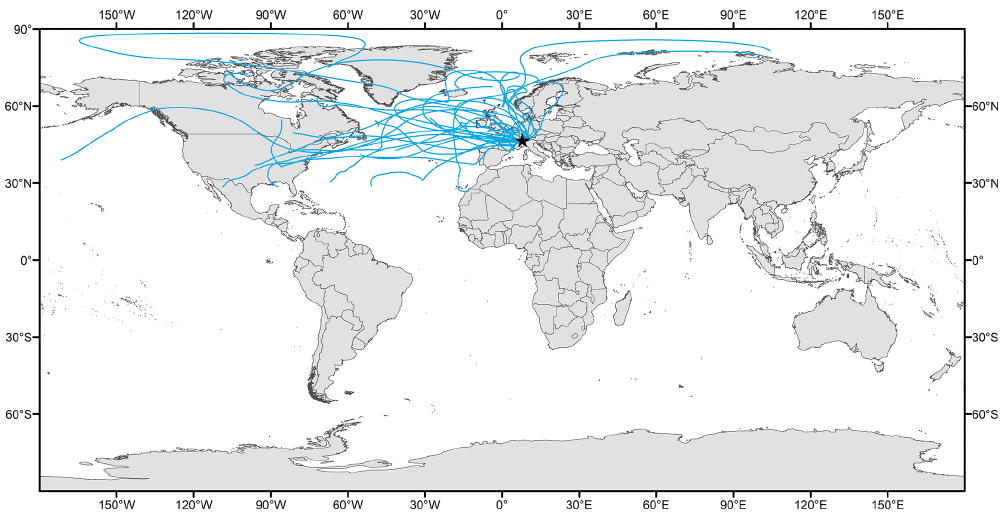
Figure 2. Ensemble of 7d backward trajectories ending at Jungfraujoch at noon local time on days for which we analysed INPs under free tropospheric conditions. The trajectories were calculated using the HYSPLIT model (NOAA Air Resources Laboratory; https://www.ready. noaa.gov/HYSPLIT.php (last access: 30 July 2021). Table 1. The INP concentration found in the free troposphere (FT) and during Saharan dust intrusions (SDIs), categorised according to heat sensitivity. The median and multiplicative standard deviation are shown. Use of the multiplicative standard deviation ( s ∗ ) is appropriate because multiplicative processes determine the concentration of biological particles in the atmosphere (Limpert et al., 2001, 2008). It was estimated from the upper (Q3) and lower (Q1) quartiles of a distribution: s ∗ = (Q3/Q1) 0 . 741 (Limpert et al., 2001). It was not estimated when the lower quartile was below the detection limit ( < 0 . 095INPm − 3 ). INPs were designated as heat sensitive if they had lost their activity after exposure to 60 ◦ C; INPs were termed moderately heat tolerant if they had retained their activity after exposure to 60 ◦ C but had lost it after exposure to 95 ◦ C; and heat-tolerant INPs were those that were still active after both heat treatments. Category INP − 10 (m − 3 ) INP − 15 (m − 3 ) FT ( n = 28) SDI ( n = 6) FT ( n = 28) SDI ( n =